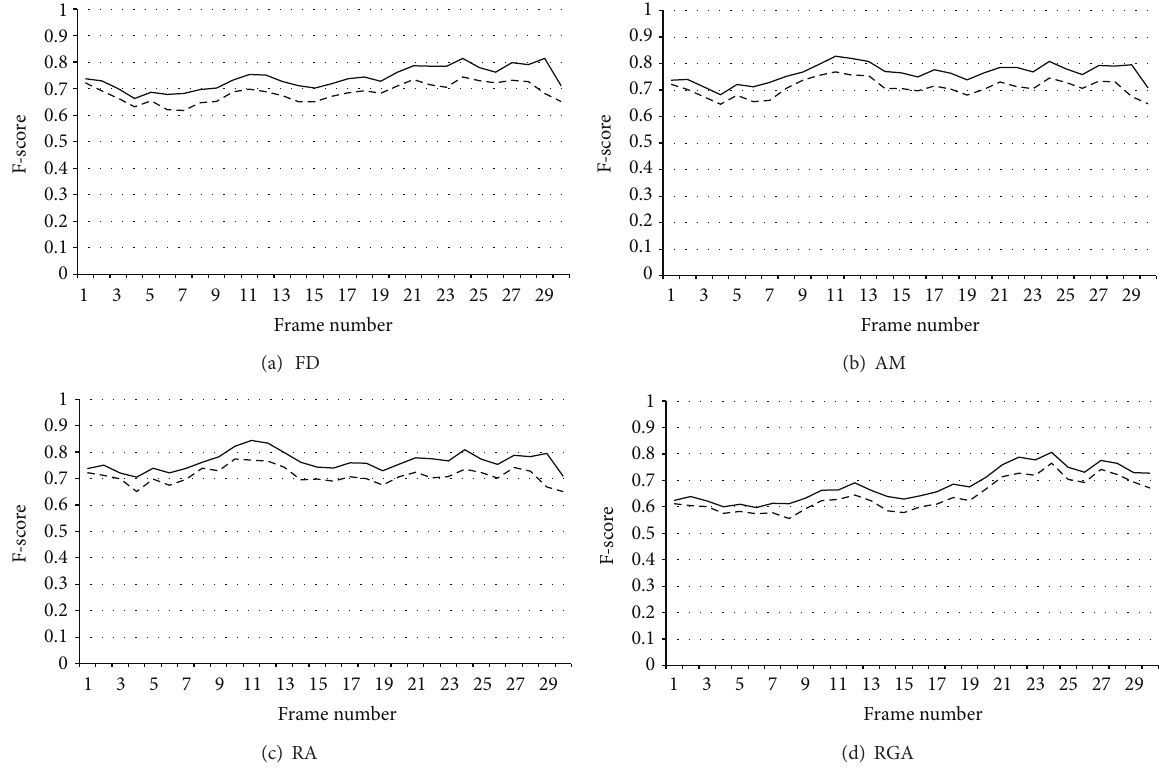
Figure 8: Graph of F- score versus frame number for indoor